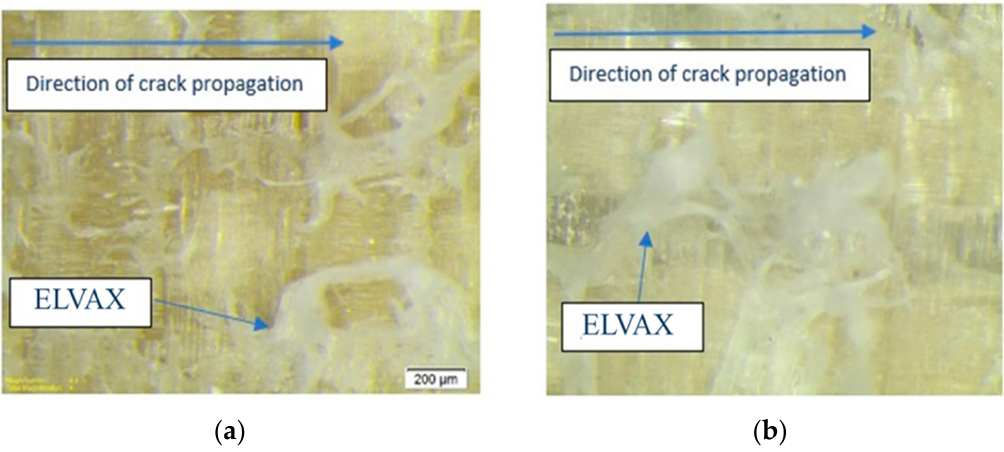
Figure 10. Optical microscopic images of Mode I specimen ( a ) Bottom surface; ( b ) Top surface.